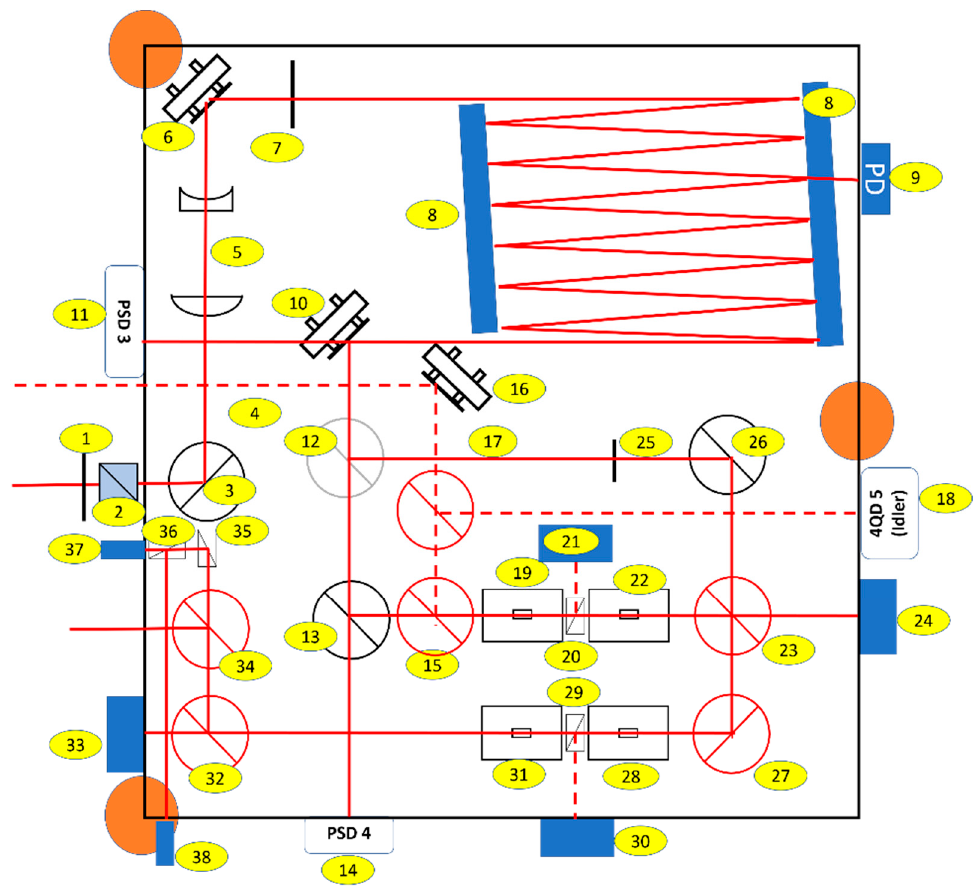
Figure 14. Scheme of the OPA setup with beam-shaping, delay-line, monitoring, and two OPA stages with two crystals each within the housing with a footprint of 400 × 400 mm 2 (dashed lines: idler beam as seeder, solid lines: pump and signal beam).